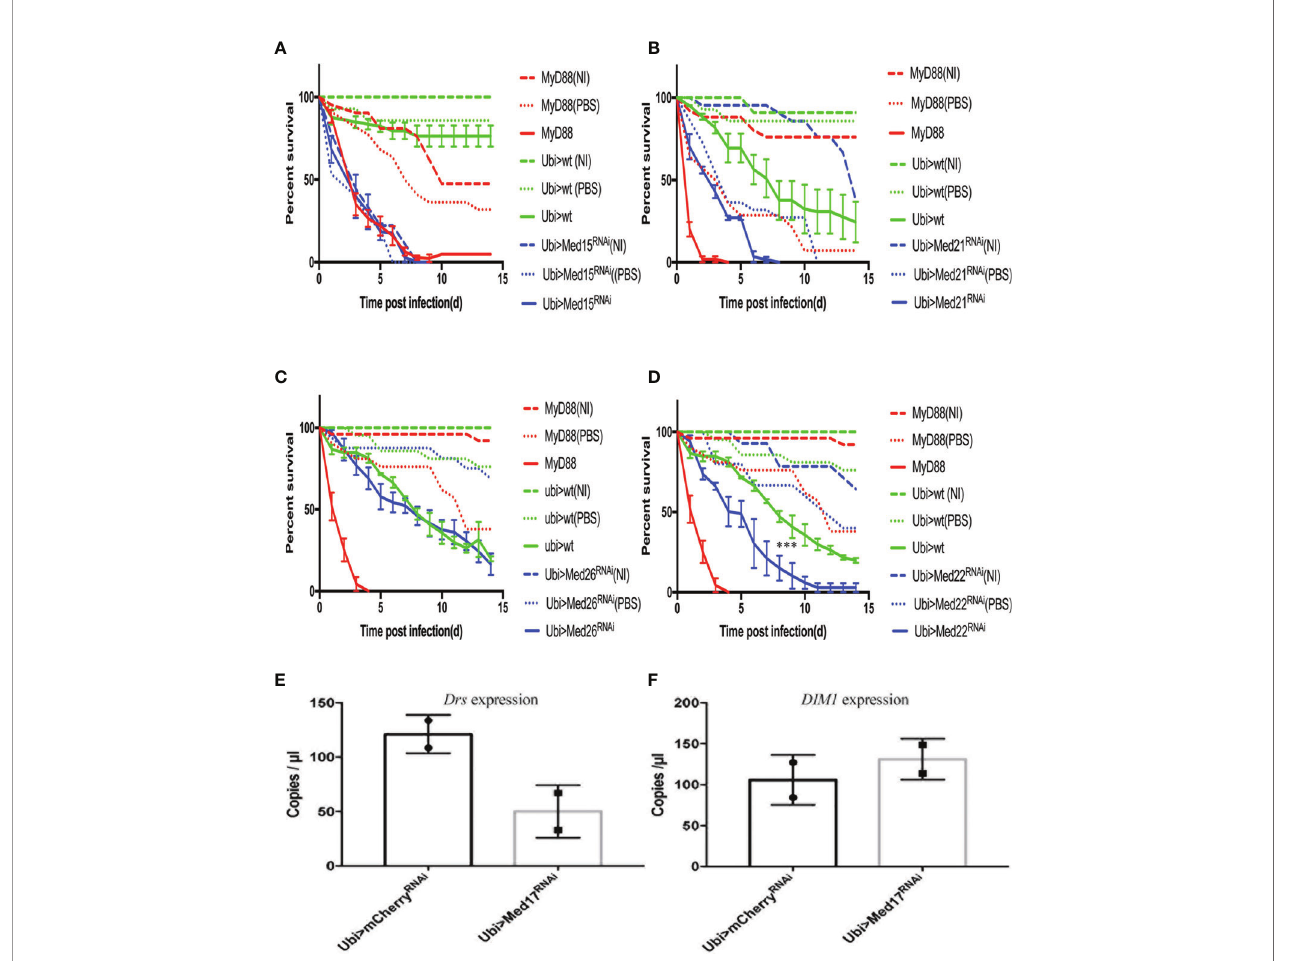
FIGURE 5 | The distinct survival phenotypic categories for other Mediator complex subunits RNAi fl ies challenged with A. fumigatus . Survival of RNAi lines targeting genes encoding other Mediator complex subunits after A. fumigatus infection. MyD88 represents the positive control line (red), Ubi> mCherry RNAi line the wild type control line (green), and Ubi> RNAi line of Mediator complex subunits is shown as a blue line. Each infected line has a non-infected (NI, dashed lines) and a PBS- injected control (dotted lines). (A) Example of a lethal phenotype, uninfected Med15 RNAi fl ies succumbed at the same rate as challenged fl ies. (B) Example of a wound-sensitive phenotype, Med21 RNAi fl ies were sensitive to the injection of PBS. (C) Example of an absence of sensitivity phenotype, Med26 RNAi fl ies did not show any enhanced sensitivity to infections. (D) Example of sensitivity to A. fumigatus infection. Med17 RNAi fl ies displayed a Med31 -like phenotype. Infected Med17 RNAi fl ies vs. infected mCherry fl ies: log-rank test, ****P < 0.001. (E, F) Expression level of Drosomycin (E) and DIM1 (F) at 48 h post A. fumigatus infection measured by digital RTqPCR. Each dot represents one sample containing fi ve fl ies. Mean ± SEM are